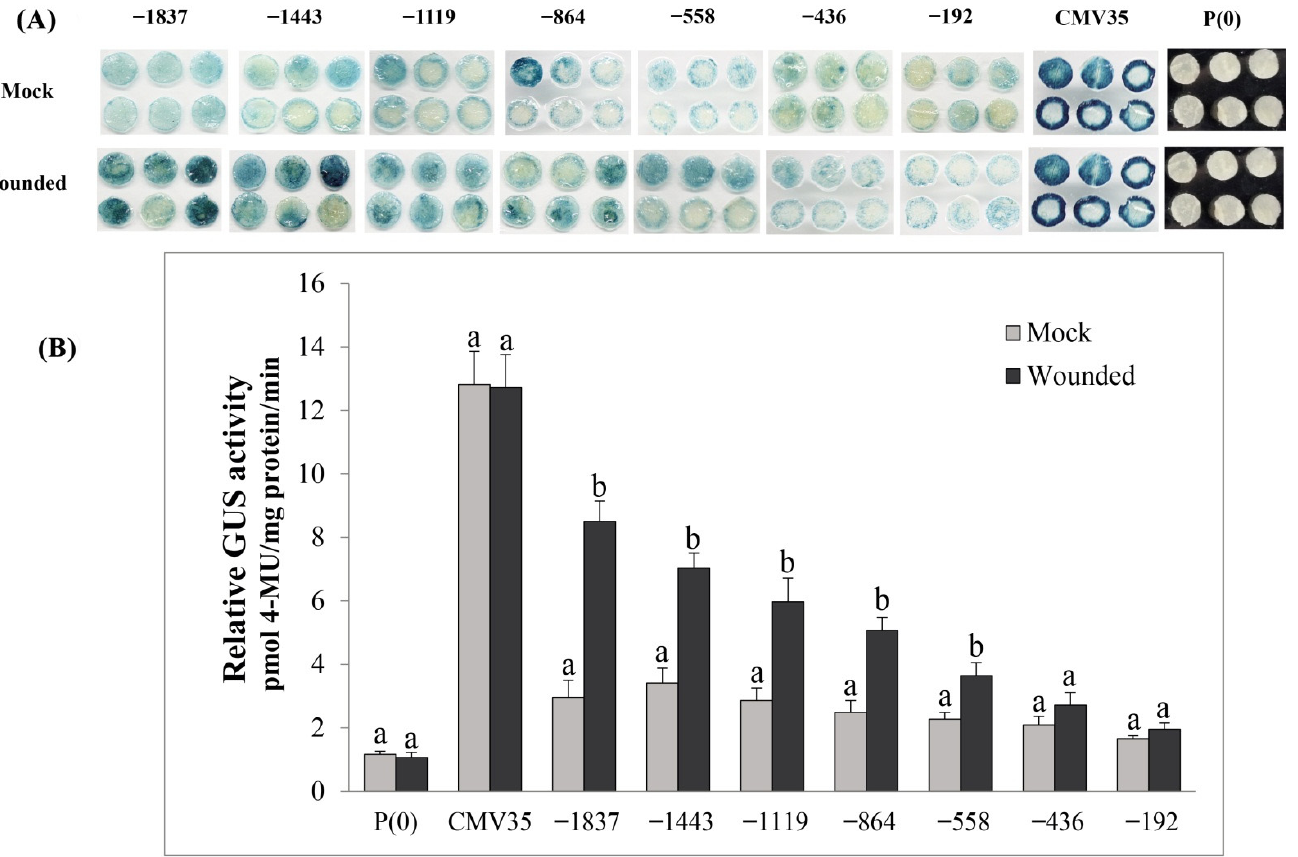
Figure 7. ( A ) Histochemical staining analysis; GUS activity in transiently transformed N. ben ‐ thamiana leaves with serially deleted VvPR1 promoter fragments ( − 1837, − 1443, − 1119, − 845, − 558, − 436, and − 192 pb) against wound stress. ( B ) VvPR1 promoter expression in response to wounding transiently transformed with the GUS reporter gene fused with VvPR1 promoter fragments in to ‐ bacco leaves. Different letters on the bars showed a significant difference according to the least significant difference (LSD) test ( p <